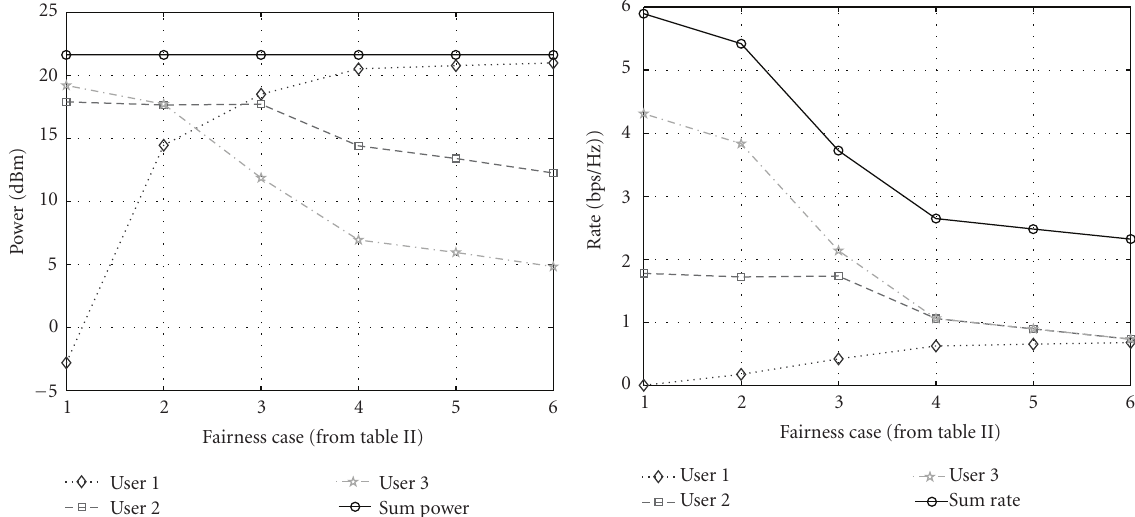
Figure 3: Sum rate maximization subject to power budget and fairness